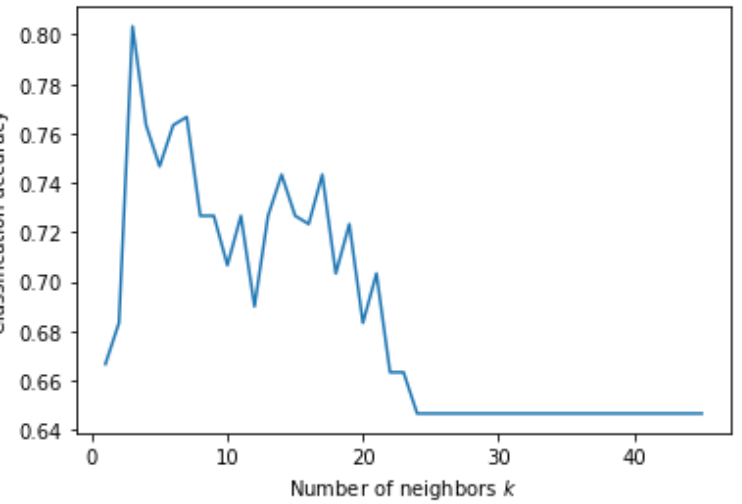
Figure 10. Classification accuracy according to k parameter of KNN on Dataset 06 when classification was based on